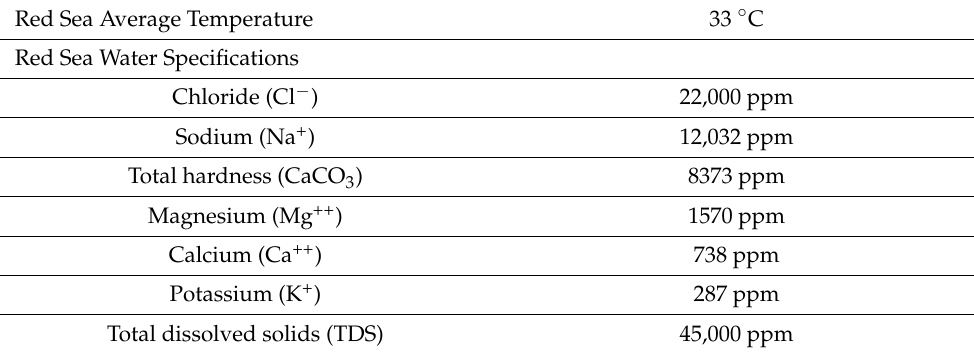
Table 2. Approximate Red Sea water